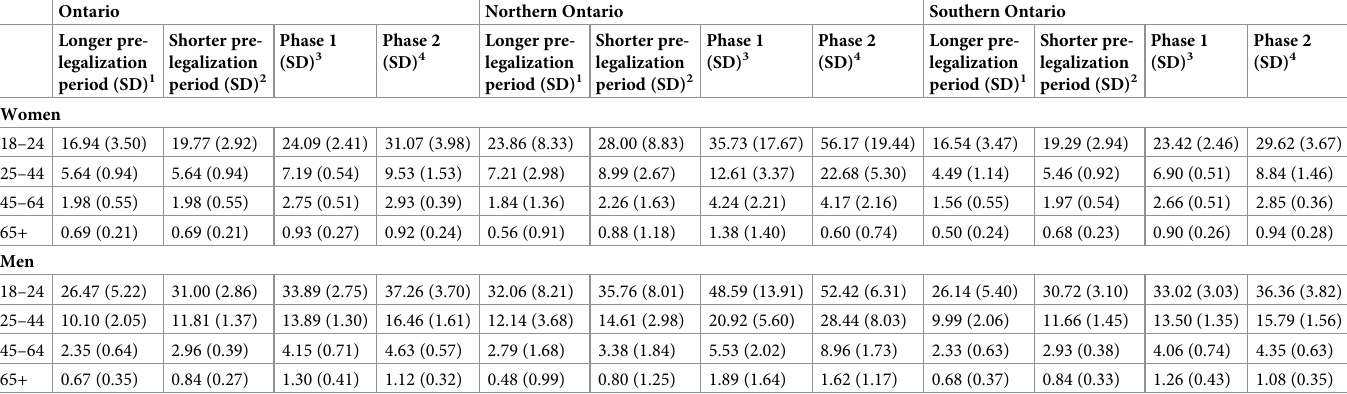
Table 2. Average monthly rate of ED visits (per 100,000 individuals) by age and gender in all of Ontario and Northern Ontario across 3 periods: 1) pre-legalization period, 2) Phase 1 and 3) Phase 3. Ontario